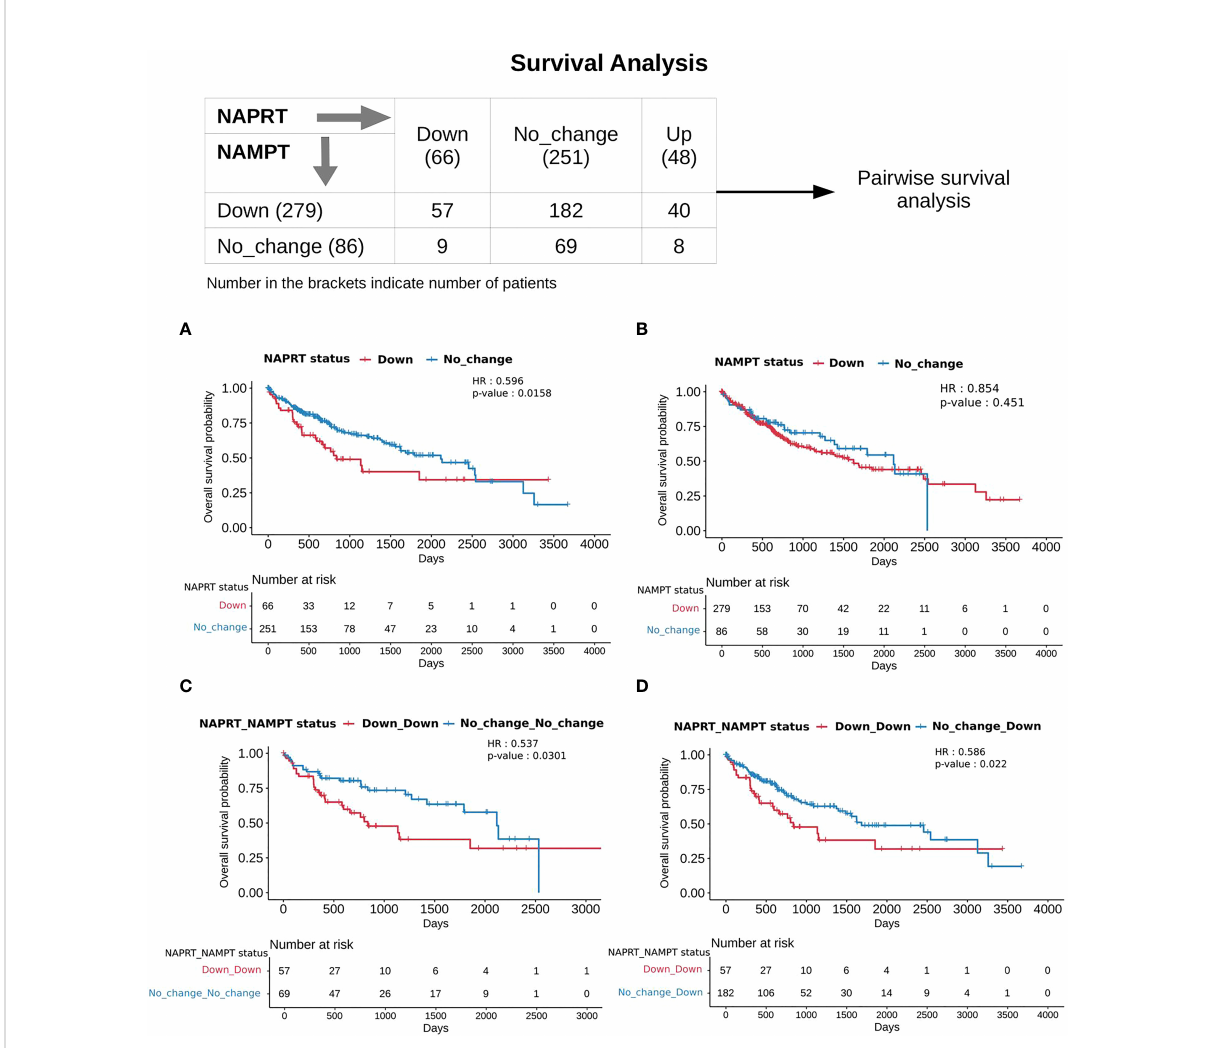
FIGURE 5 NAPRT_NAMPT Down_Down status corresponds to poorer survival. The panel on the top shows the distribution of patients into groups based on the NAPRT and NAMPT gene expression status. Kaplan-Meier Overall survival curve for HCC patients classi fi ed based on NAPRT Down and No_change groups (A) NAMPT Down and No_change groups (B) , NAPRT_NAMPT Down_Down versus No_change_No_change groups (C) , and NAPRT_NAMPT Down_Down versus Down_No_change groups (D) . HR and p-values reported in the fi gure panels are for the group represented in blue